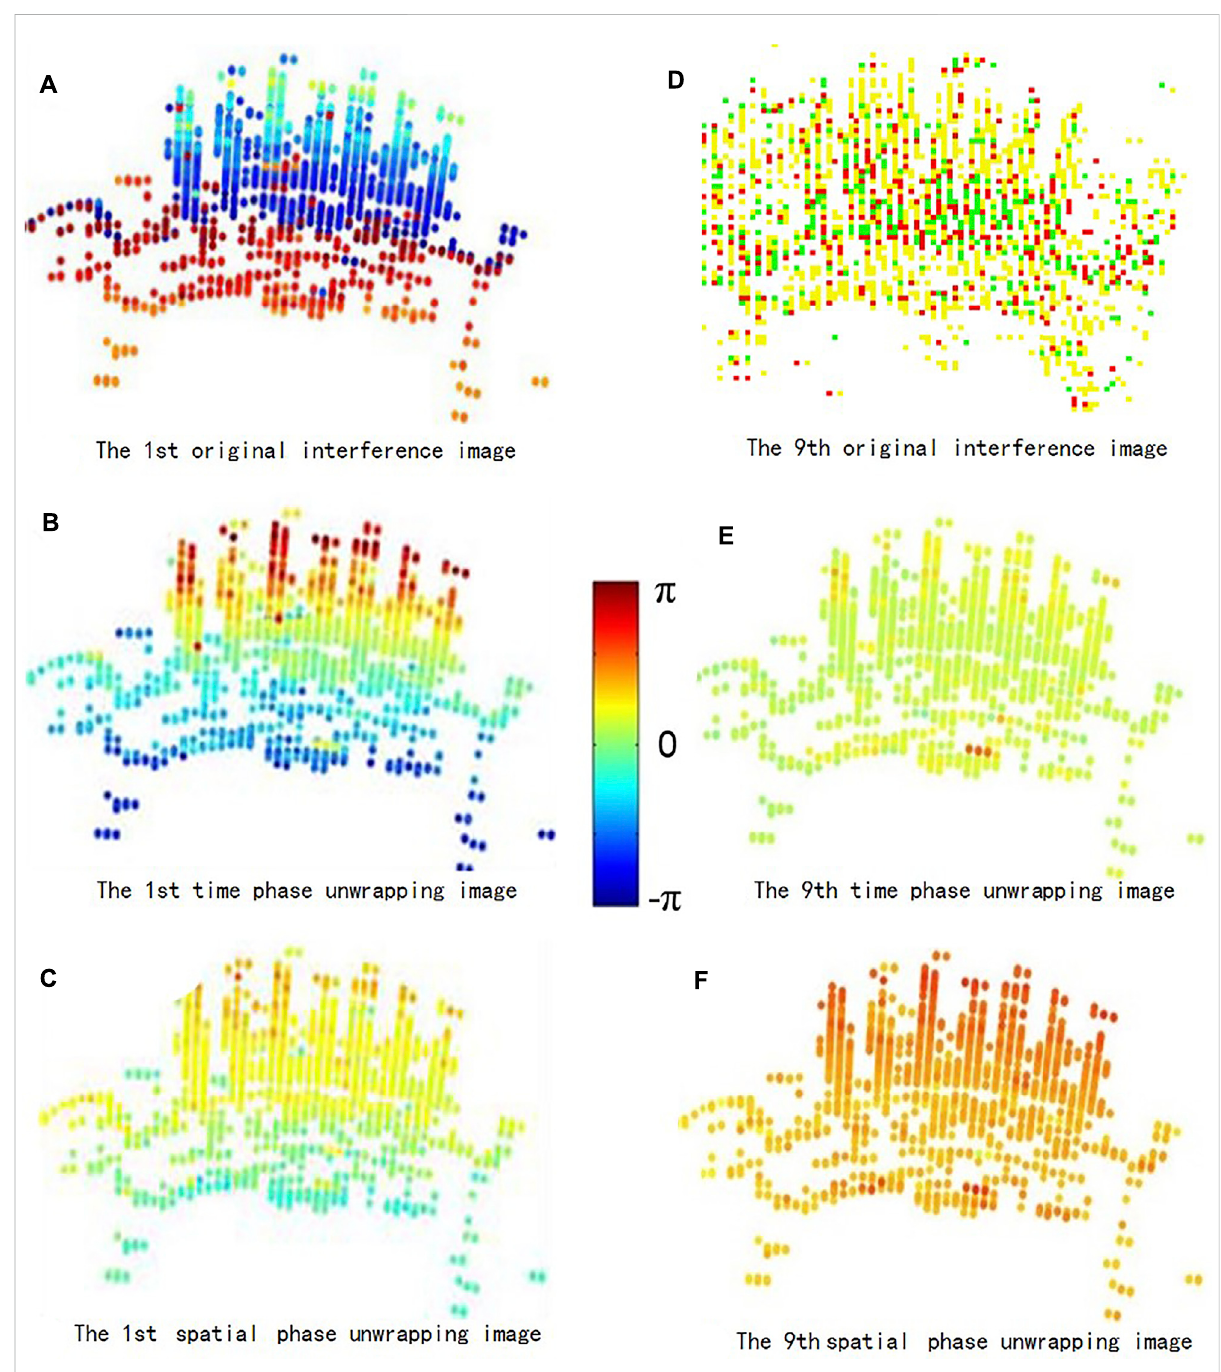
FIGURE 6 Comparison of the fi rst image and the ninth image before and after phase